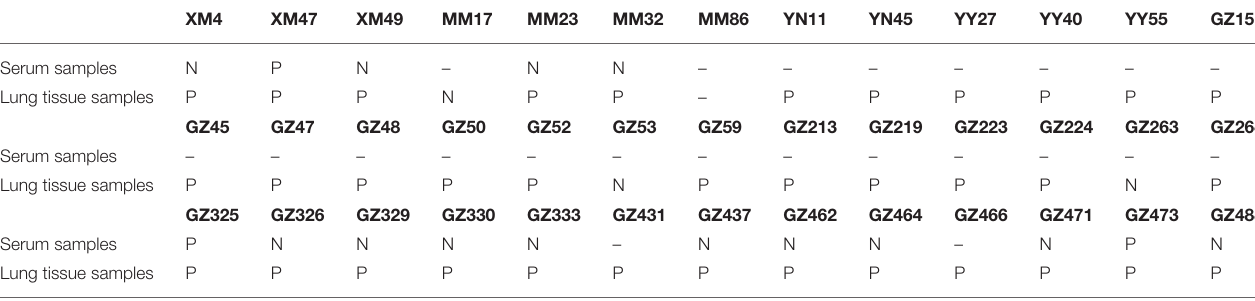
Serum samples Lung tissue